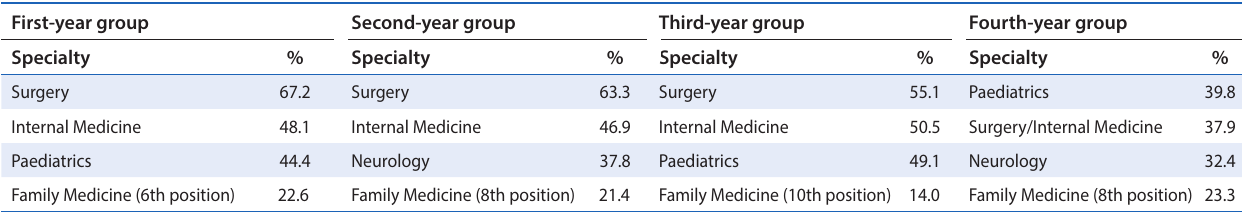
Table 1: Top three likely specialties and Family Medicine per year group First-year